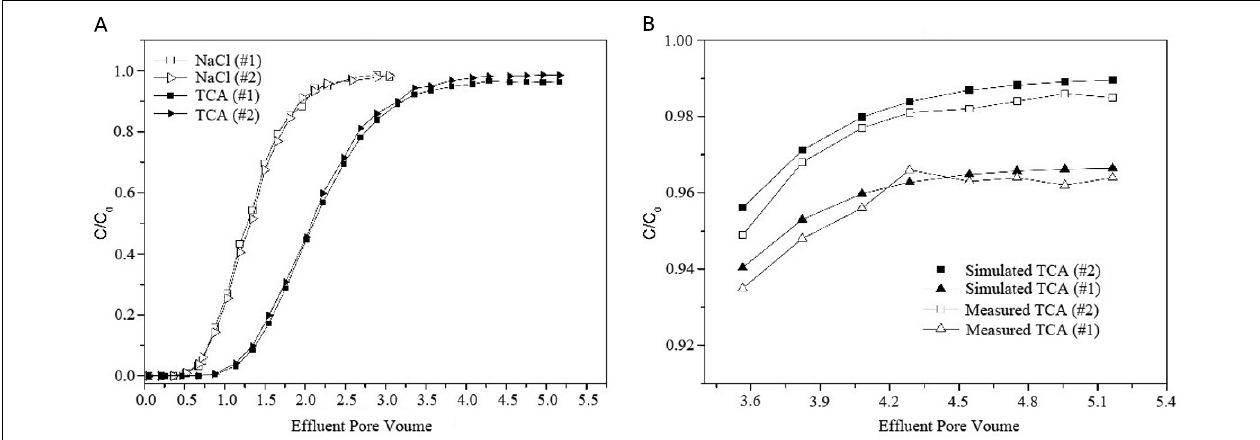
FIGURE 2 | The effluent breakthrough curves in column experiments. (A) Effluent concentration of 1,1,1-TCA and NaCl. (B) Simulated and Measured curves of 1,1,1-TCA.